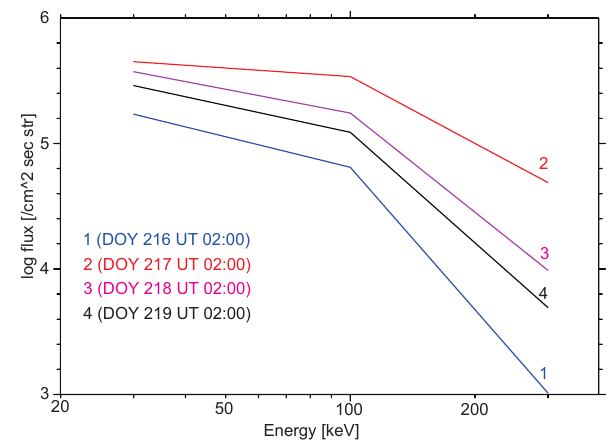
Fig. 3. Electron energy spectrum during the initial phase (spec- trum 1), the main phase (spectrum 2), and the recovery phase (spec- trum 3, 4) of the DOY 217